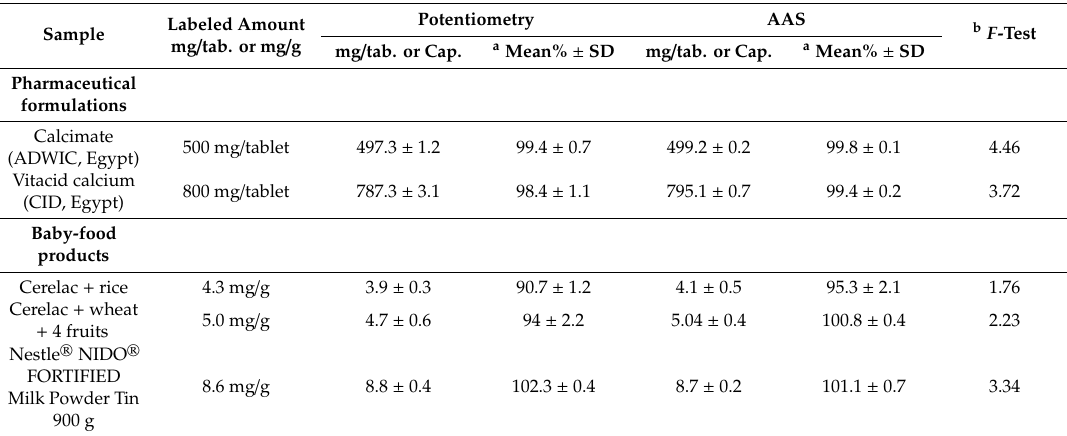
Sample b F -Test mg/tab.